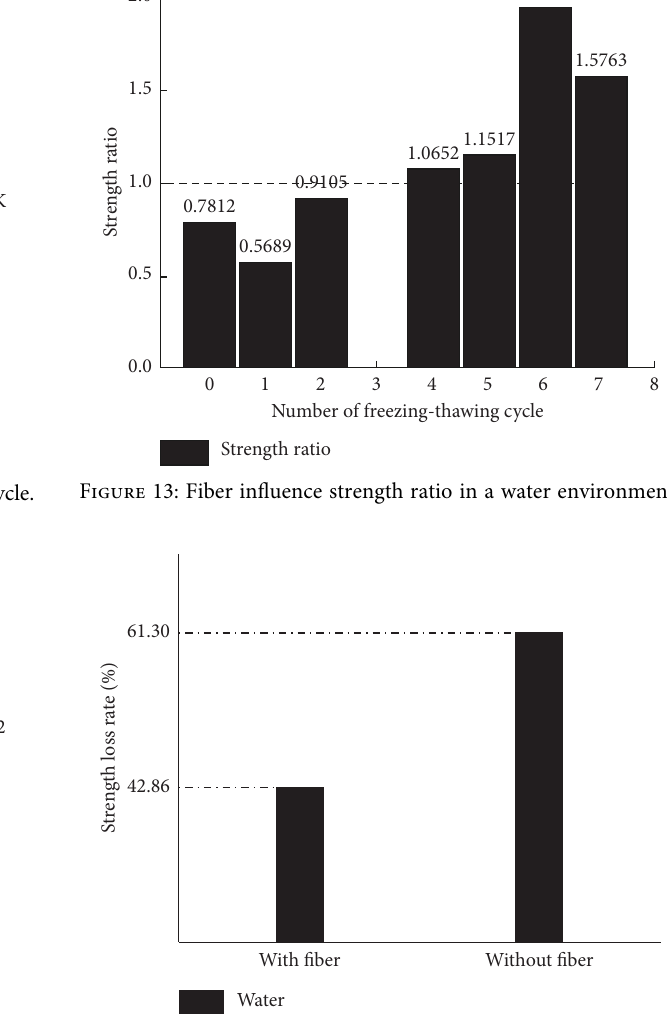
Figure 14: Strength loss rate of cement-soil test block after the 5th freezing-thawing cycle in a clean water